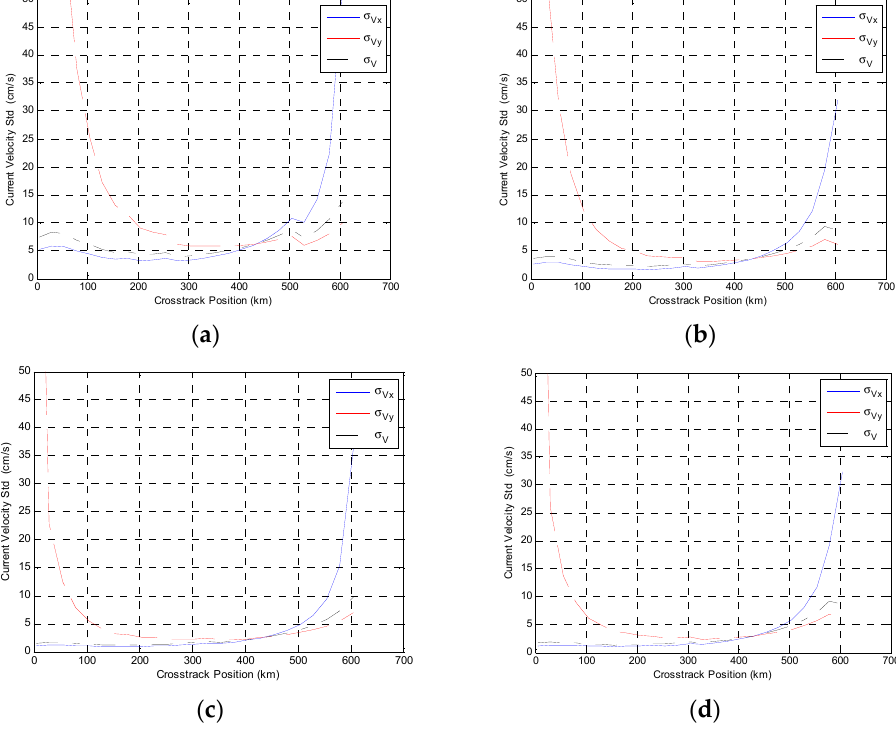
Figure 21. Surface current velocity components Std in line-of-sight, cross-track, and along-track direction: ( a ) U = 4 m/s; ( b ) U = 7 m/s; ( c ) U = 14 m/s; ( d ) U = 21 m/s. Overall, the current field effective swath is small in low wind speeds, but it has good performance in high wind speeds, as shown in Figure 21. In order to analyze the current field effective swaths of different current velocity Stds with different wind speeds more directly, we examined Table Table 12. Current field effective swaths of different current velocity Stds in different wind speeds. Wind Speed (m/s)/Current